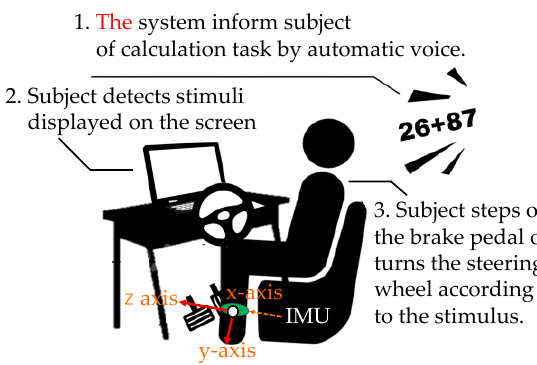
Figure 6. Subject performs dual task.